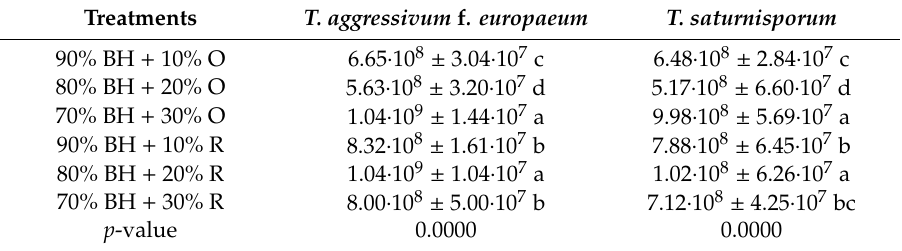
Table 1. Mass production of spores on solid substrates (CFU g − 1 ). Treatments